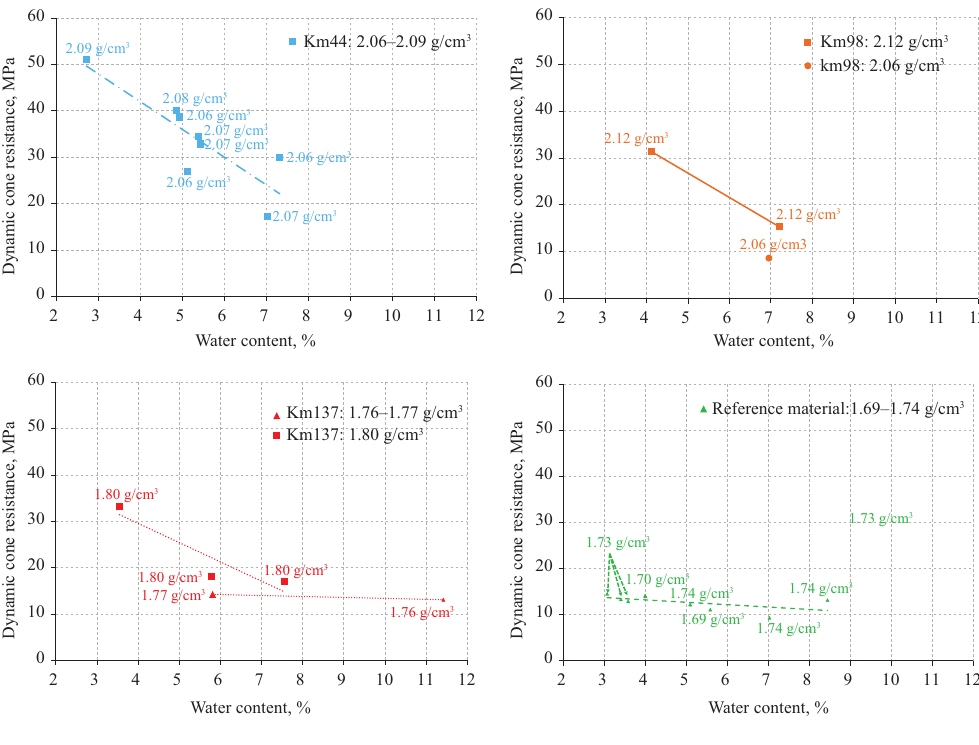
Figure 8. The impact of moisture content on dynamic cone